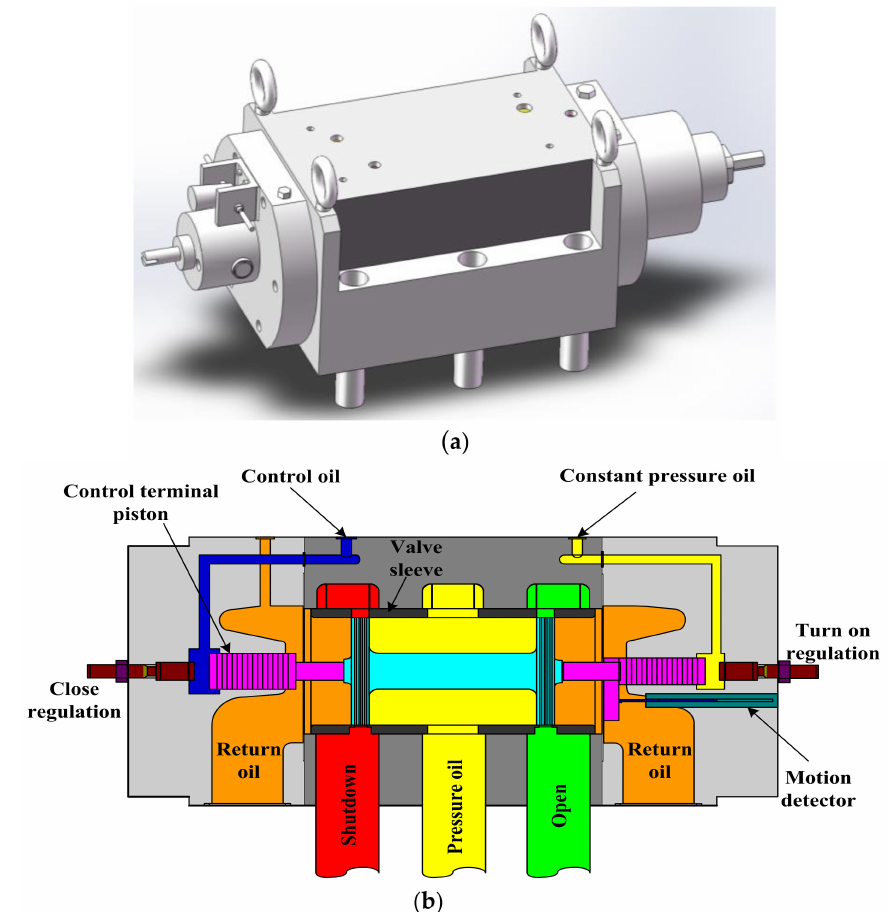
Figure 1. Structure of the main pressure regulating valve. ( a ) Sketch of the main pressure-regulating valve; ( b ) Diagram of the main pressure valve